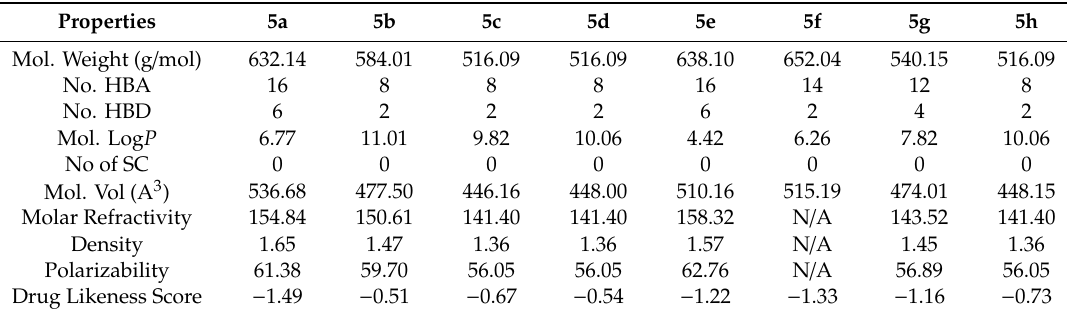
Table 2. Cheminformatics